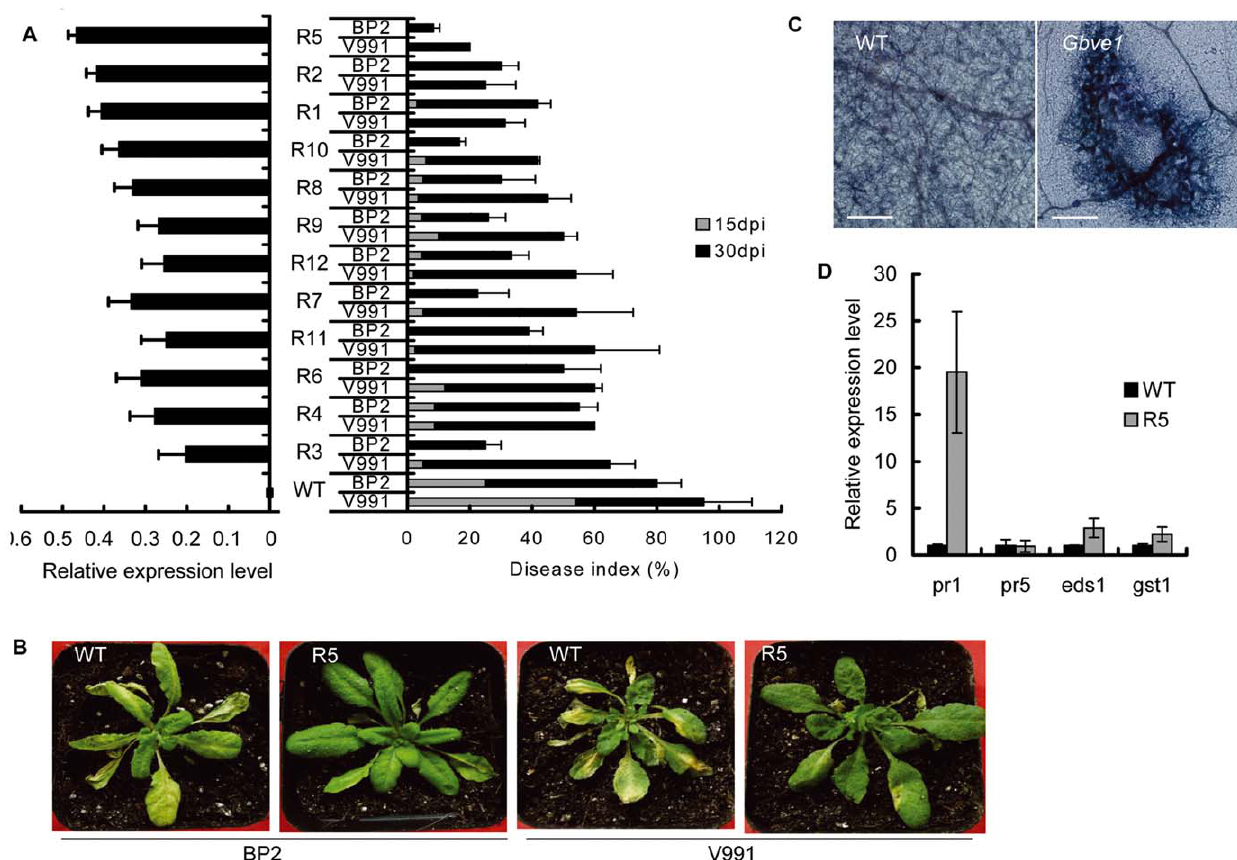
Figure 5. Gbve1 confers Verticillium wilt resistance in transgenic Arabidopsis . (A). The resistant levels of transgenic Arabidopsis (left panel) to V. dahliae was related to the expression levels of the Gbve1 gene in the T 3 independent transgenic lines (right panel). The disease indices were presented means 6 SE from three replications with at least 16 plants per replication. (B). Phenotype comparison of transgenic line R5 and WT infected with V. dahliae isolates V991 and BP2. (C).The Gbve1 transgenic Arabidopsis were resistance to V. dahliae through cell death response. Bar=200 m m. (D). Expressional levels of genes relative to pathogen resistance in transgenic line R5.